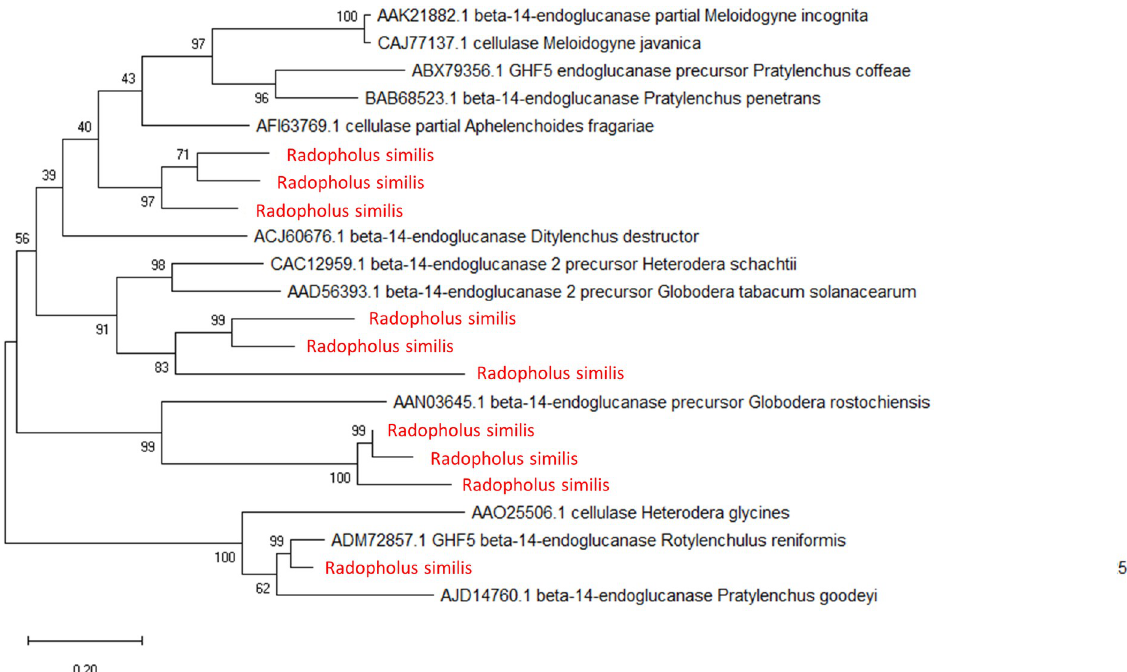
Fig 1. Evolutionary analysis of cellulase genes. Phylogenetic analysis based on concatenated alignments of 22 cellulase protein sequences from multiple plant-parasitic nematode in clade 10 and clade 12. The evolutionary history was inferred by using the maximum-likelihood method with the best-fit (WAG+G+I) substitution model predicted using MEGA X. Numbers indicate bootstrap values. 1000 bootstrap replications were performed. R . similis cellulase genes are highlighted in red. Evolutionary analysis was performed using MEGA X.